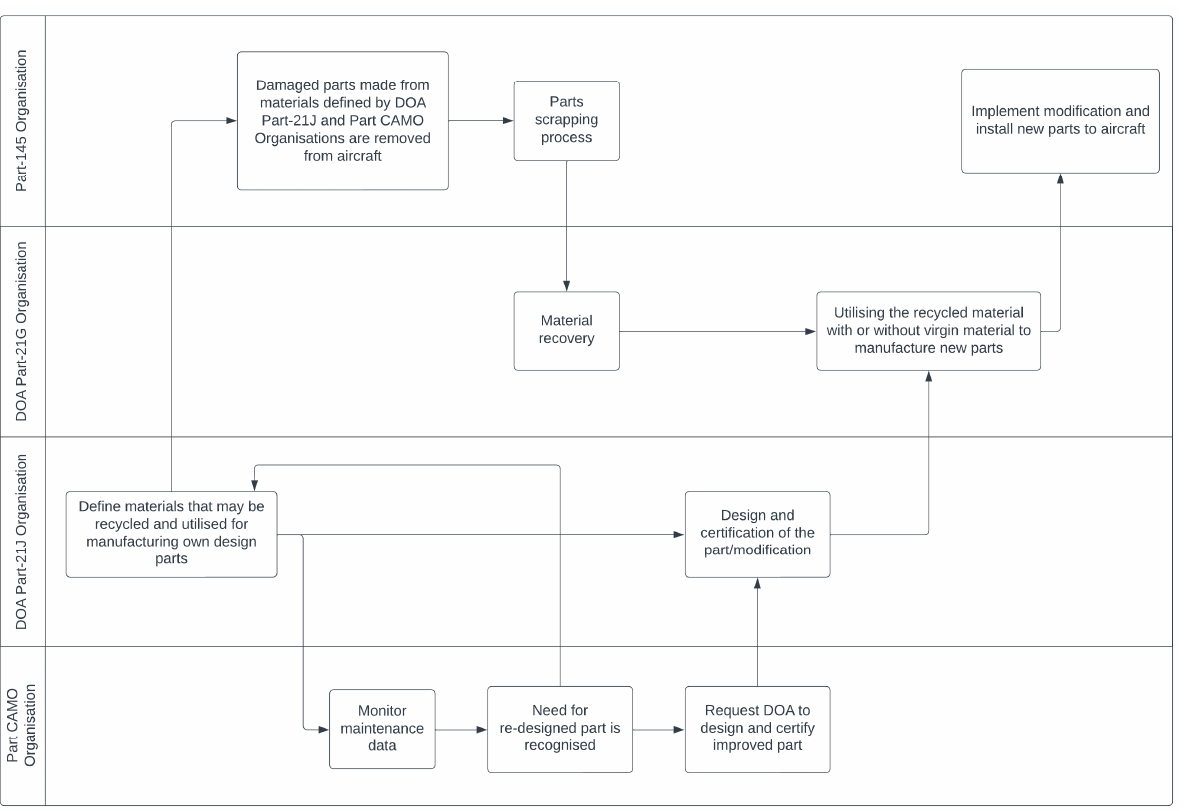
Figure 2. An outline for process description of an airline running closed-loop recycling.